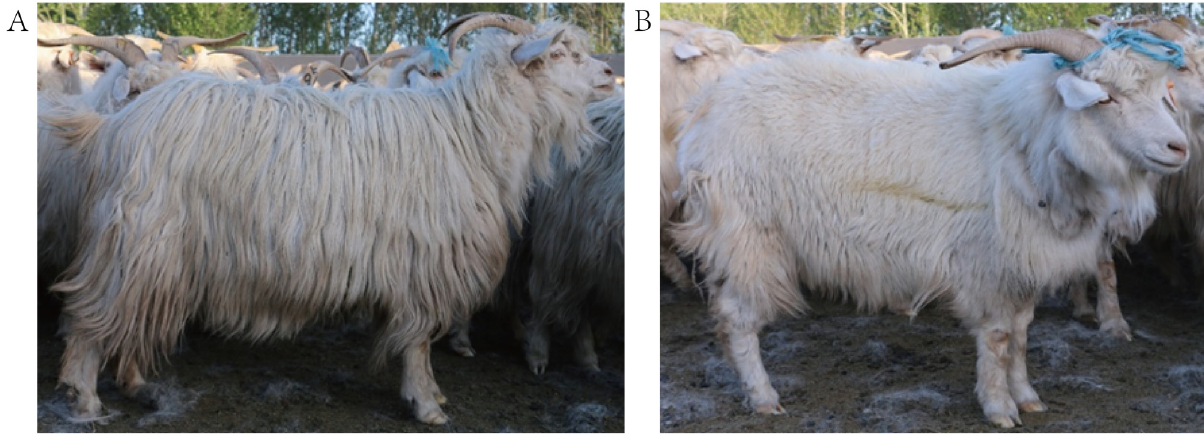
Figure 1. Photographs of long-hair-type and short-hair-type cashmere goats. ( A ) Long-hair-type cashmere goat, ( B ) short-hair-type cashmere goat.